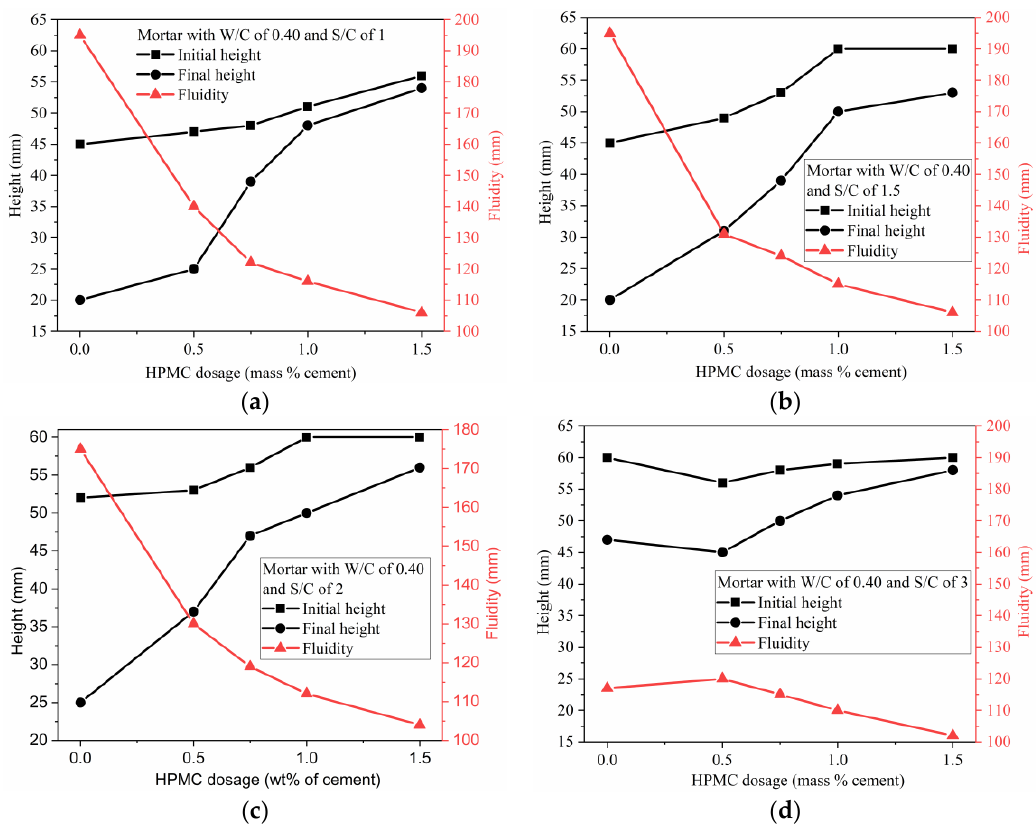
Figure 10. Initial height, final height and fluidity of SAC mortar Vs. HPMC dosage with maintaining W/C of 0.40: ( a ) mortar with S/C ratio of 1; ( b ) mortar with S/C ratio of 1.5; ( c ) mortar with S/C ratio of 2; ( d ) mortar with S/C ratio of 3.